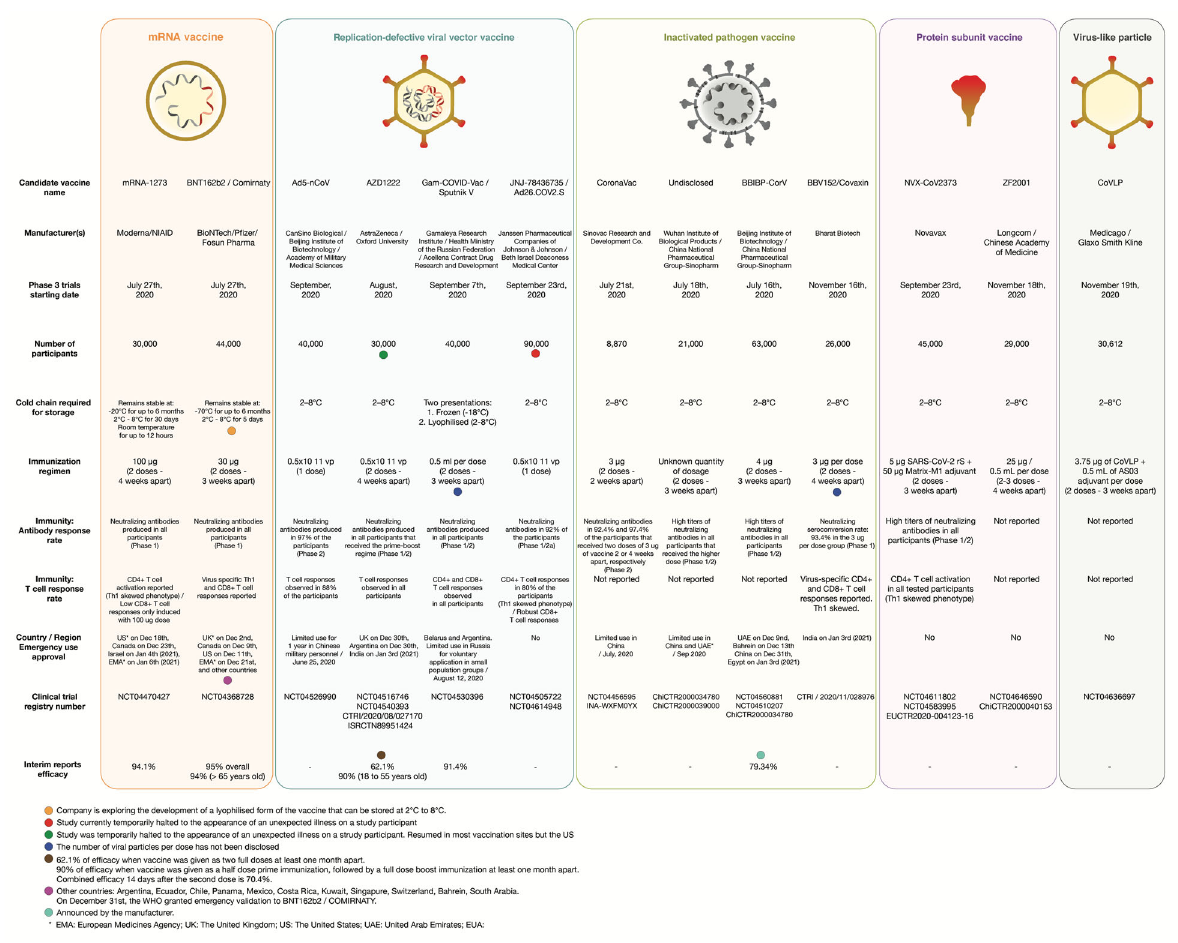
Fig. 1 Most advanced SARS-CoV-2 vaccine candidates. The vaccine candidates are grouped according to the platform technology used for their development: mRNA vaccines, replication-defective viral vector vaccines, inactivated pathogen vaccines, protein subunit vaccines, and virus-like vaccines. Manufacturer name, Phase 3 trial data, immunogenicity and current status information are herein detailed. EMA European Medicines Agency, UK The United Kingdom, US The United States, UEA United Arab